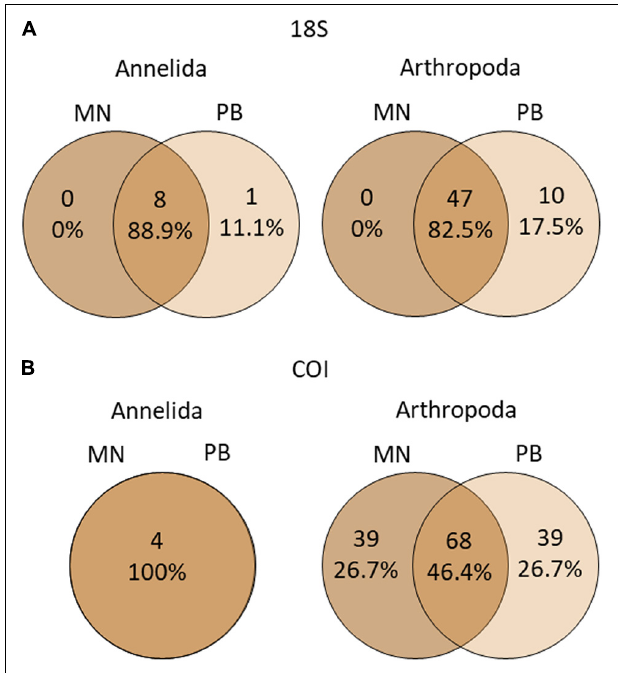
FIGURE 6 | Venn diagram showing number of shared and unique Annelida and Arthropoda species (blastID ≥ 99%) per extraction method for the (A) 18S and (B) COI